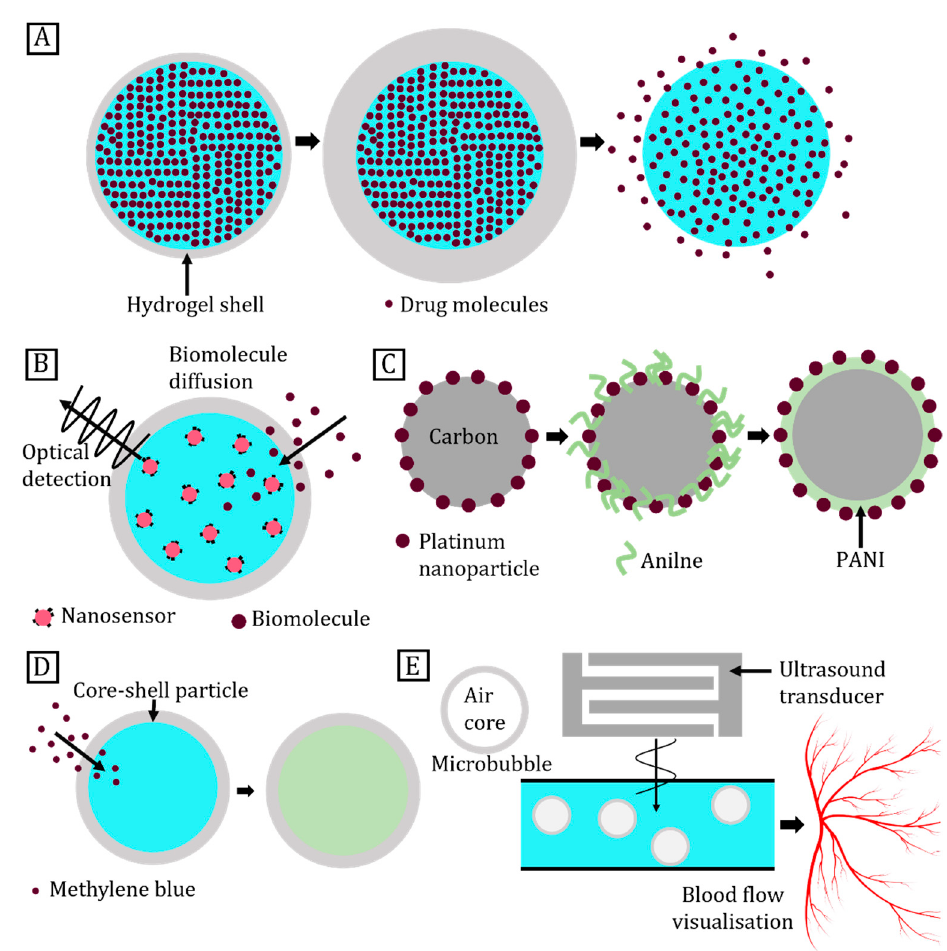
Figure 2. Typical applications of core–shell particles. ( A ) Chitosan core–shell particle for drug release; ( B ) Core–shell particles for biomolecule sensing and release; ( C ) Carbon-platinum-PANI (polyaniline) core–shell particles as catalysis; ( D ) Core–shell particle for methylene blue detection; ( E ) Schematics showing enhanced ultrasound imaging of blood capillaries after microbubble infusion.